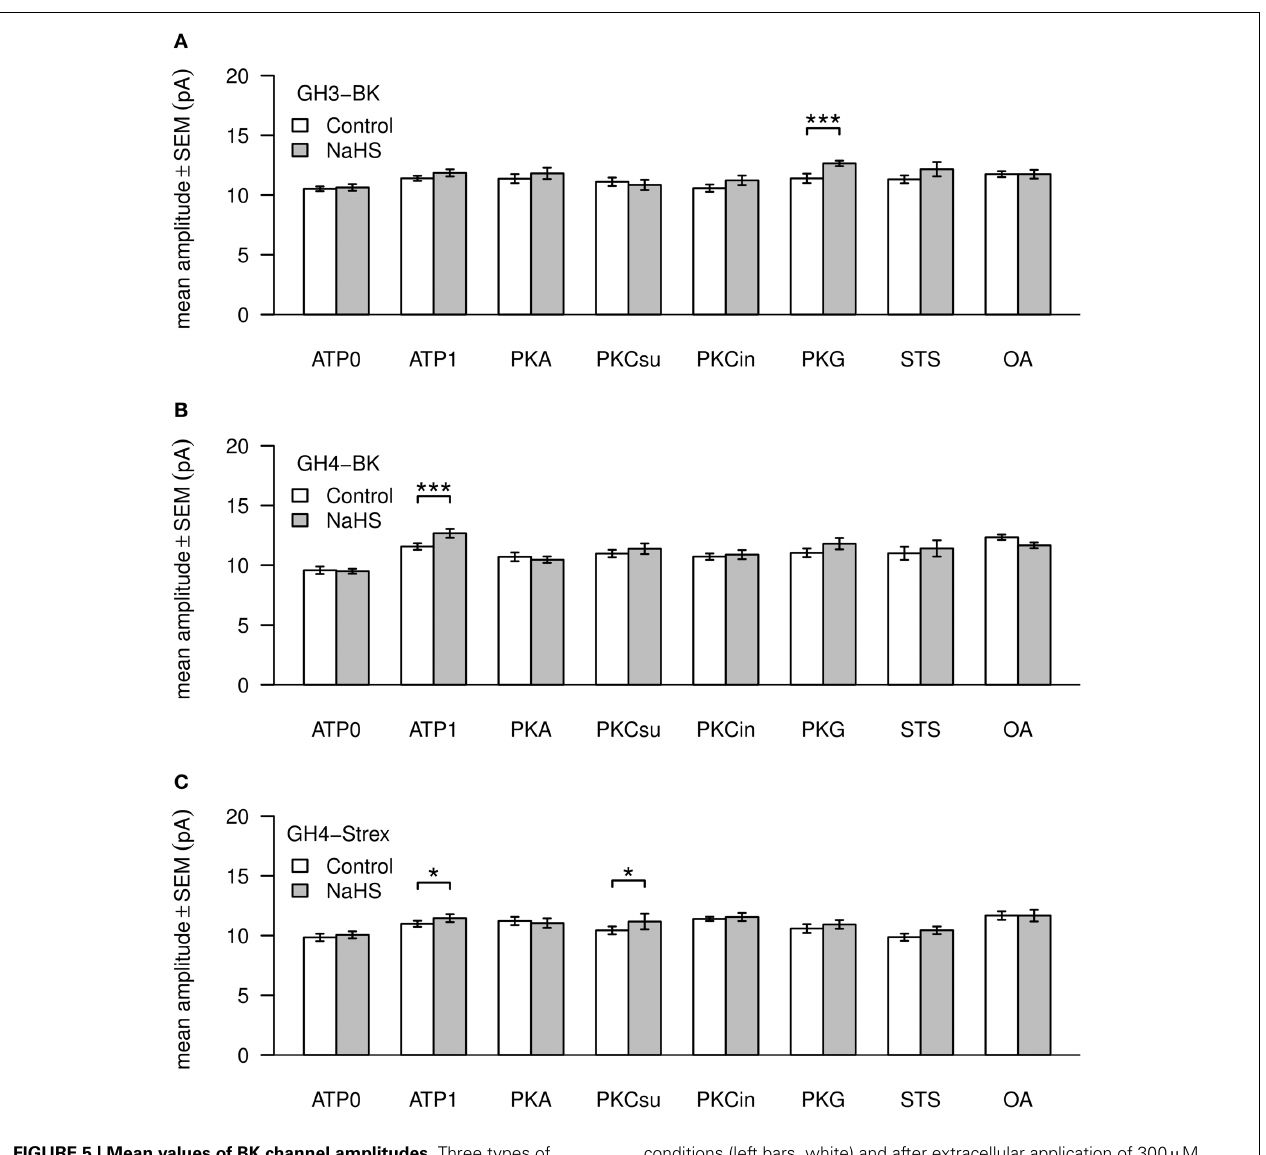
FIGURE 5 | Mean values of BK channel amplitudes. Three types of channels—GH3-BK (A) , GH4-BK (B) , and GH4-STREX (C) cells were investigated. Bar graphs show amplitude values in pA under control